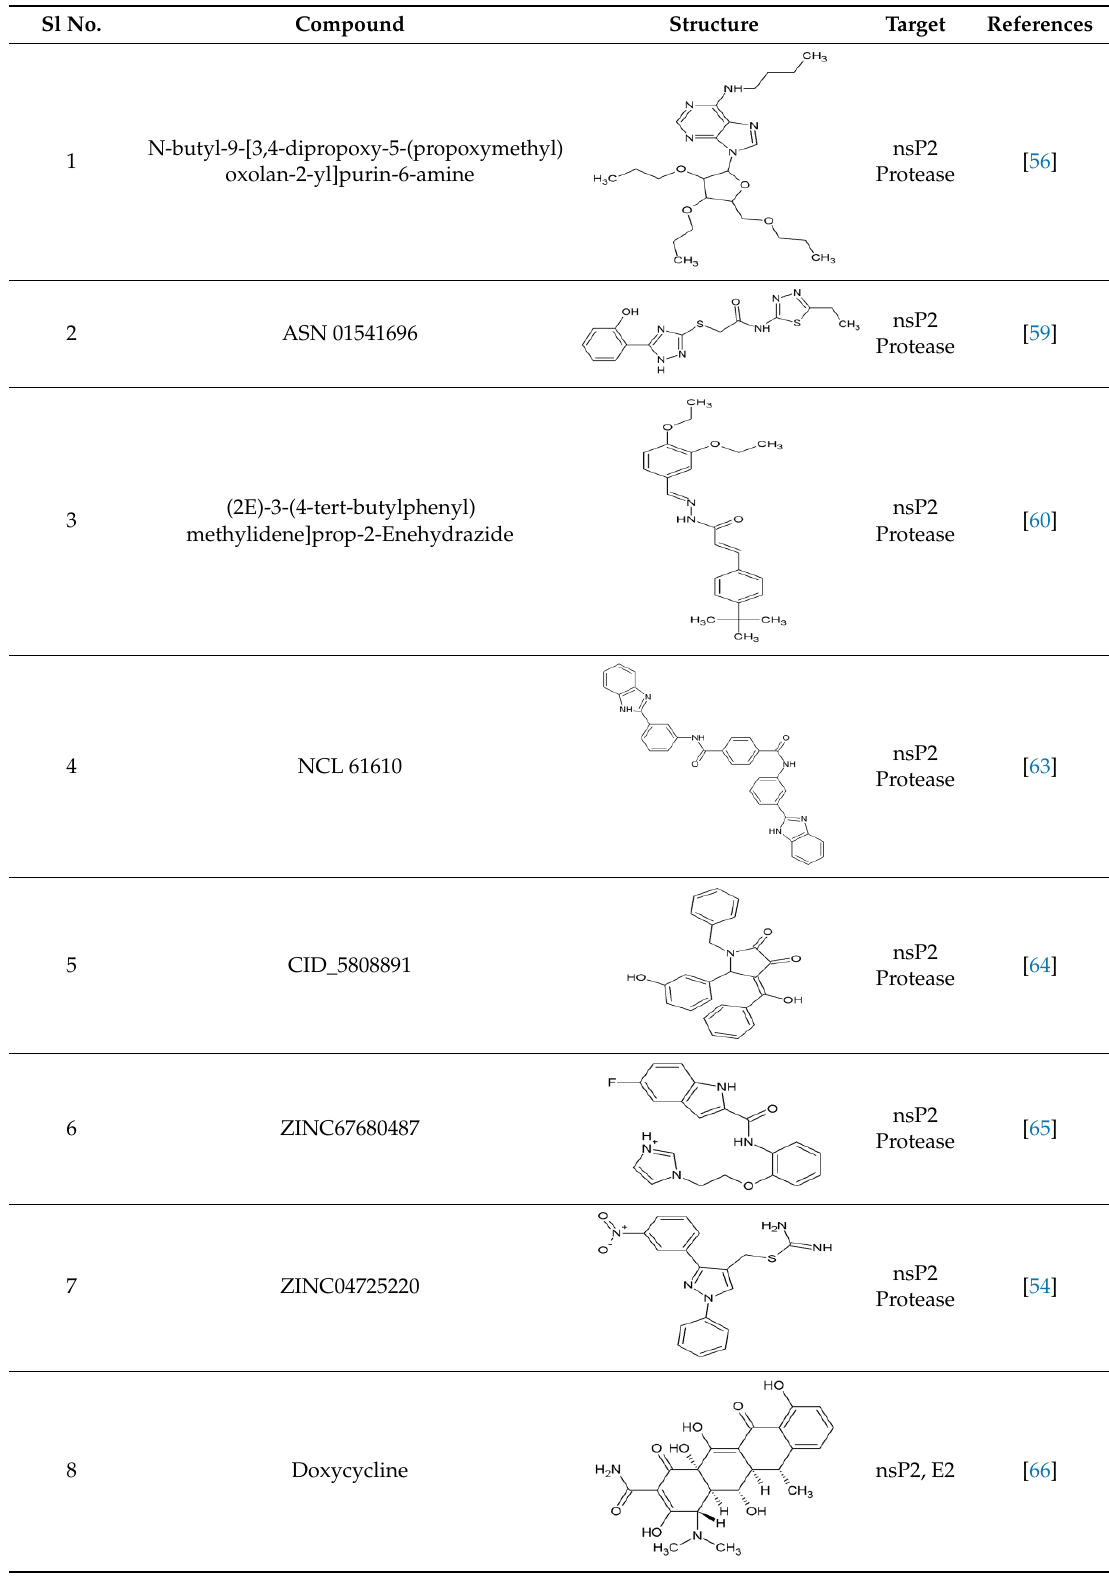
Table 1. Compounds identified as CHIKV inhibitor by in silico screening. Sl No.